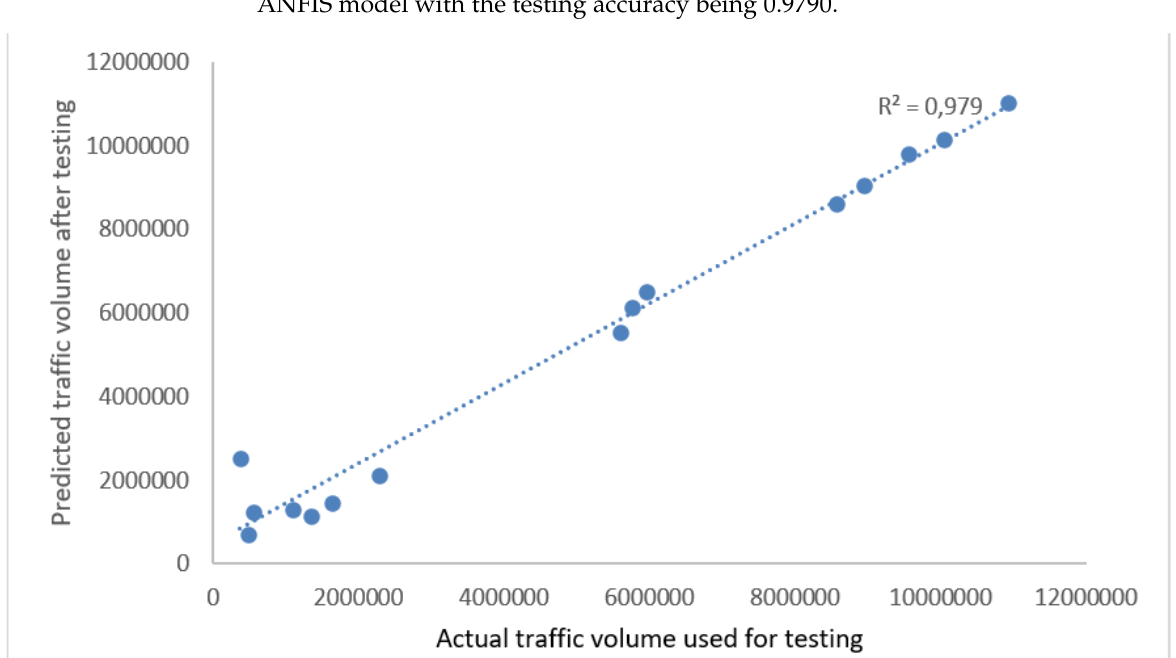
Figure 19. ANFIS model training accuracy. The observed and predicted output of the traffic volume of vehicles at the road intersections were compared in Figure 20 to determine the accuracy of the testing of the ANFIS model with the testing accuracy being 0.9790.